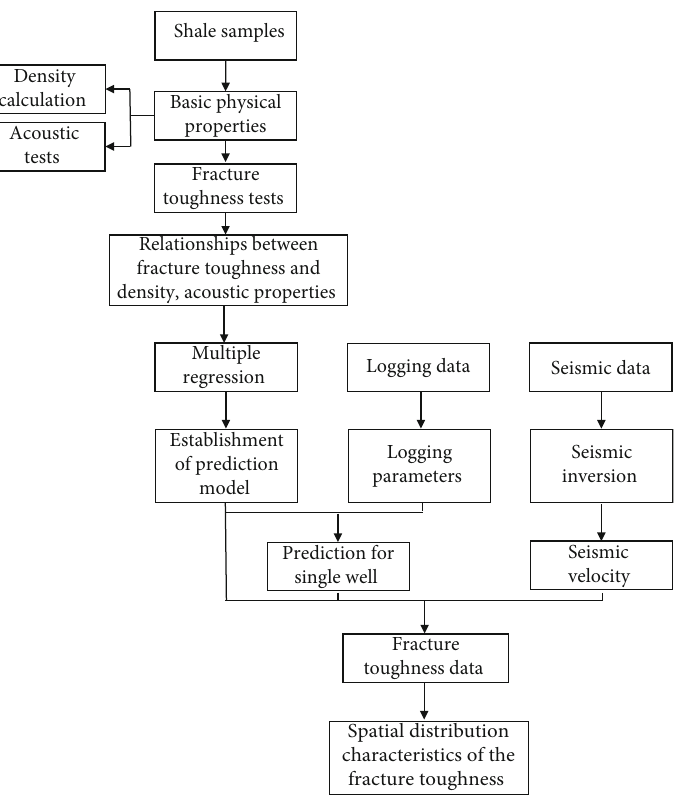
Figure 3: Flow chart of prediction on shale fracture toughness.